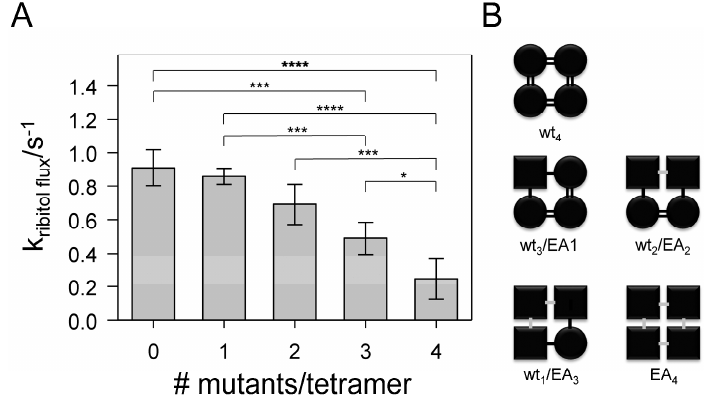
Figure 4. Impact of the number of EA ‐ mutated protomers per tetramer on GlpF activity. ( A ) The measured rate constants of the fused GlpF tetramers plotted against the proportion of E43A ‐ mutated monomers. The rate constants of fused GlpF tetramers are depicted as mean values ( n = 3 ± SD). In the case of the fused heterotetramer EA 4 , the rate constant after normalization to the expression level is shown. Statistical analyses (one-way ANOVA, Tukey-test) yielded a p -value < 0.001 for the overall comparison. Statistically significant differences observed in a pairwise analysis are indicated in the figure: p < 0.001 (****), 0.001 < p < 0.01 (***), 0.05 < p < 0.1 (*). ( B ) Schematic depiction of interactions between individual GlpF monomers, with WT protomers having the strongest interactions ( = ), followed by weaker interactions between a WT and a mutated protomer ( - ) and weakest interactions between two mutated monomers ( ‐ ).